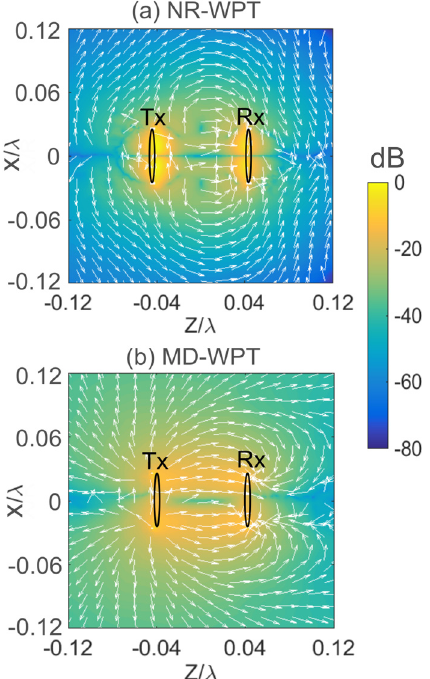
Figure 8: Poynting vector S streamlines and magnitude for (a) NR-WPT system at the frequency of 408.6 MHz and (b) MD-WPT system at the frequency of 278 MHz. Poynting vector magnitudes are normalized to their maximum values and shown in log scale. 𝜆 is the operation